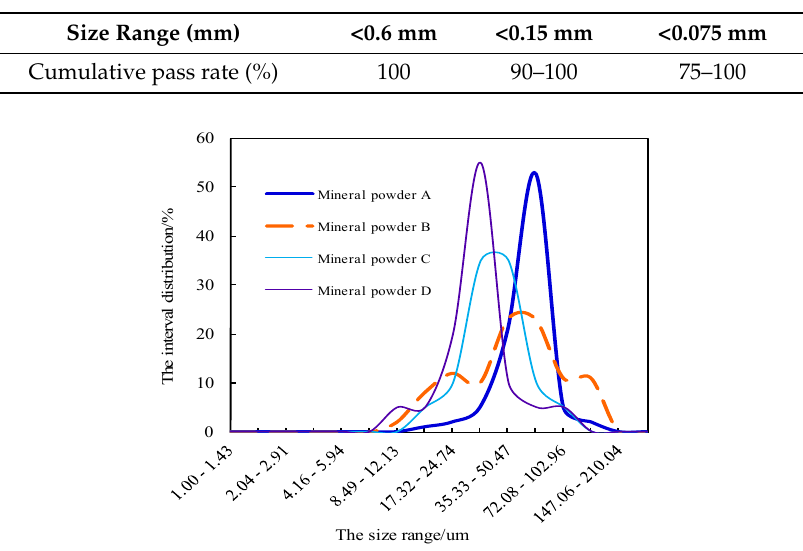
Table 2. Basic Requirements on the Size Range of Mineral Fillers in China.